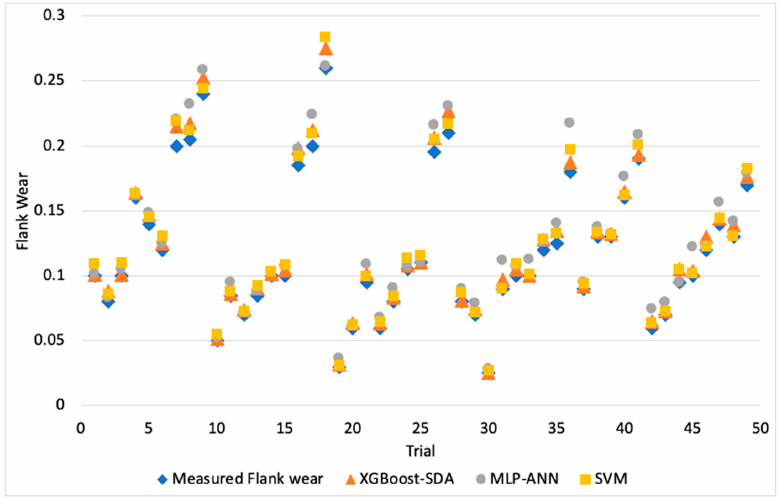
Figure 3. Flank wear values vs. predicted flank wear values of a drilling process (Copper workpiece).